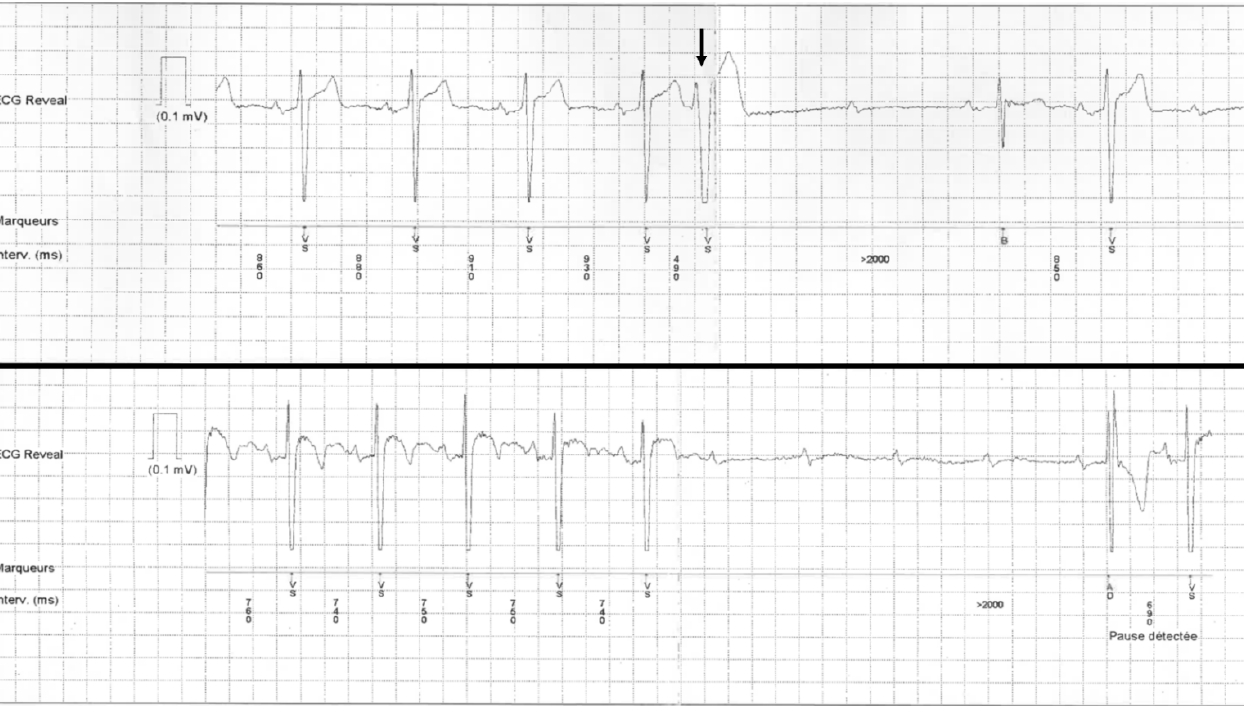
Figure 5. Example of pause-dependent atrioventricular block induced by a premature ventricular contraction (arrow), and recorded with an implantable loop recorder. In the same patient, another episode was preceded by sinus rhythm acceleration (from 760 to 740 ms) corresponding to tachycardia-dependent atrioventricular block.